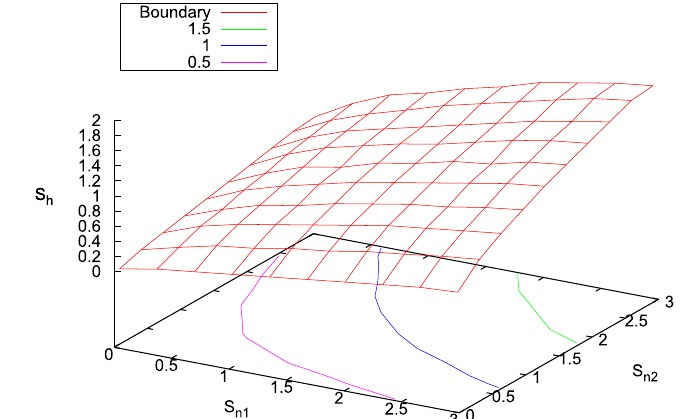
Fig. 17 Frequentist 90% confidence-level exclusion and inclusion regions for the simulated data with Λ = 7 . 6. The 90% exclusion region E obs lies below the red surface. The green , blue and magenta curves are projections of the S h = 1 . 5 , 1 . 0 , 0 . 5 level surfaces of the boundary onto the ( S n